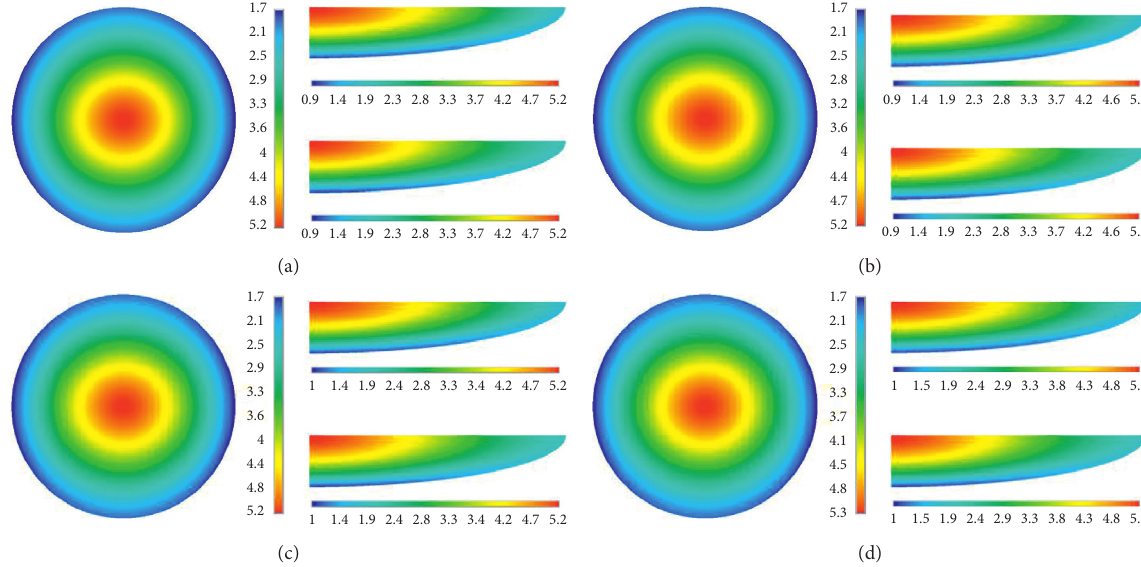
Figure 6: The displacement amplitude of the homogeneous sedimentary basin ( f � 0.5 Hz): (a) no buildings; (b) buildings 14 × 14; (c) buildings 20 × 20; (d) buildings 26 × 26.